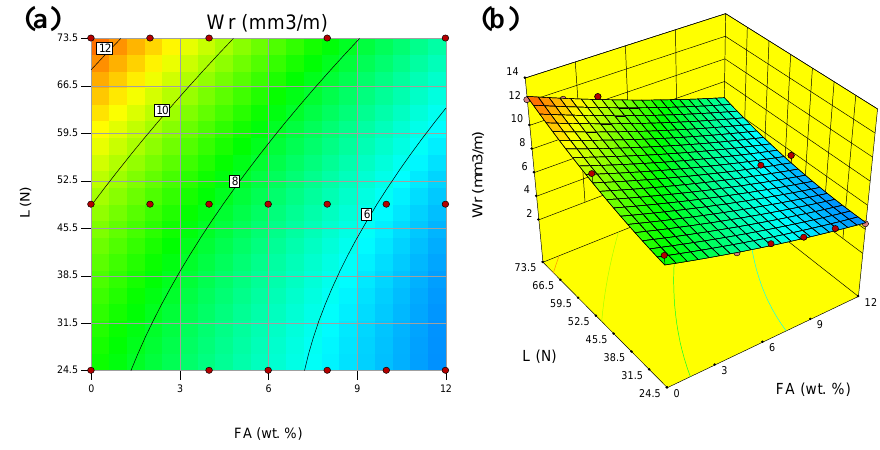
Figure 5. FA and L contour showing the interactive effect on Wr, ( a ) contour lines, ( b ) 3D.